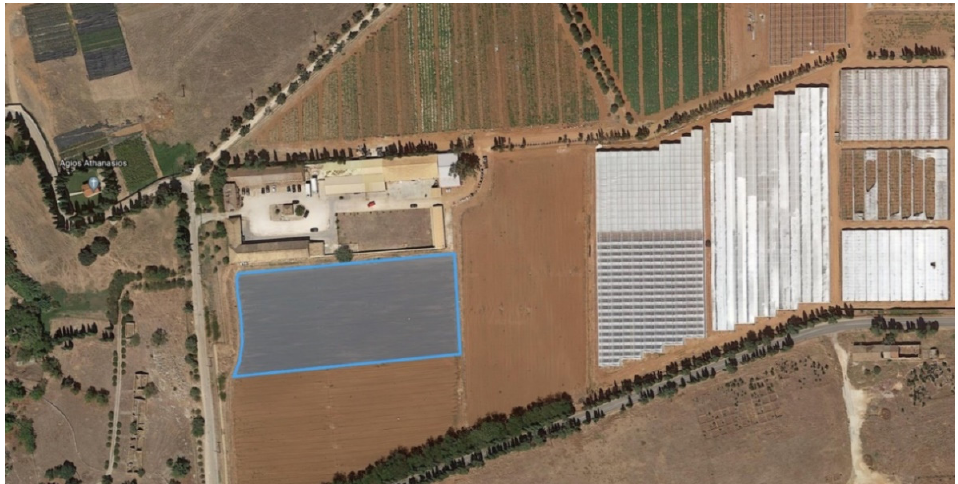
Figure 3. The field segment where the experiment took place.